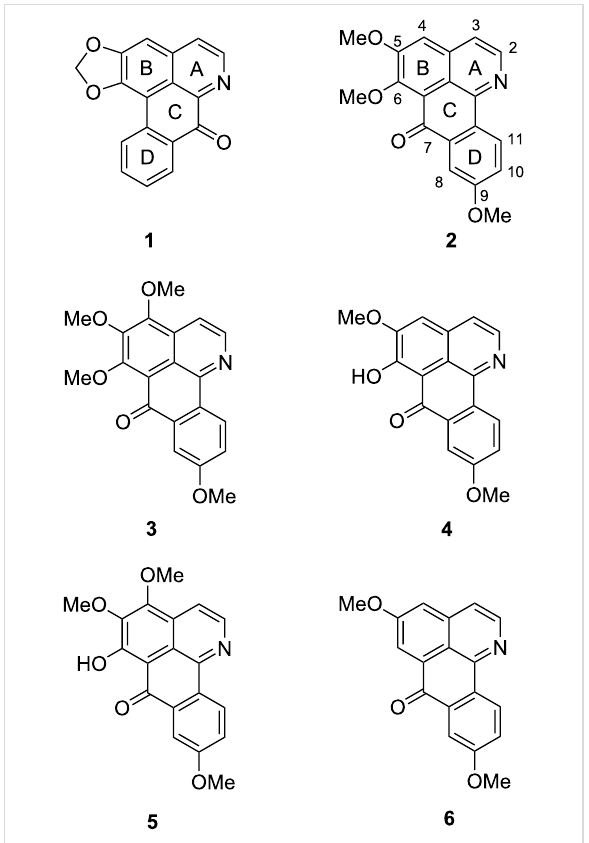
Figure 1: Prominent oxoaporphine and oxoisoaporphine alkaloids: liriodenine ( 1 ), menisporphine ( 2 ), dauriporphine ( 3 ), 6- O -demethyl- menisporphine ( 4 ), dauriporphinoline ( 5 ), and bianfugecine ( 6 ).